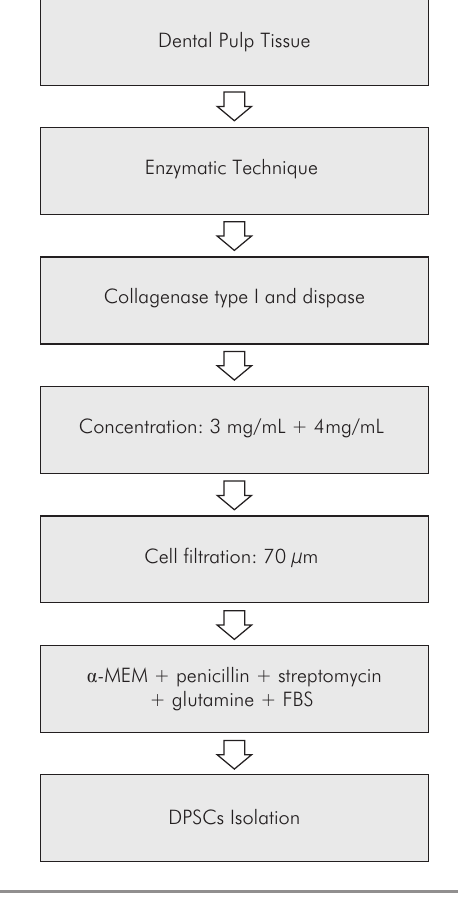
Figure 3. Flowchart summarizing the principal results obtained from this systematic review, highlighting the most commonly used steps for DPSCs